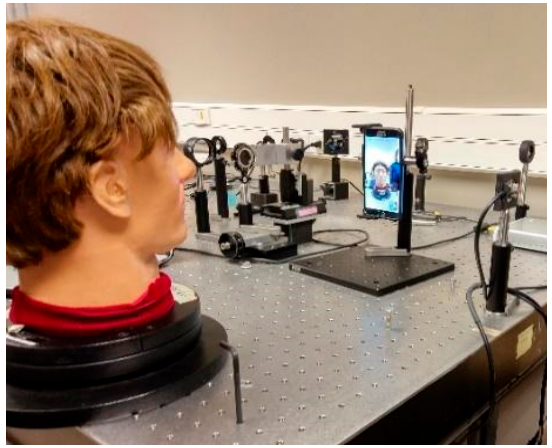
Figure 3. Facial illuminance being measured for a mannequin using a Samsung S6 Edge Plus smartphone camera.